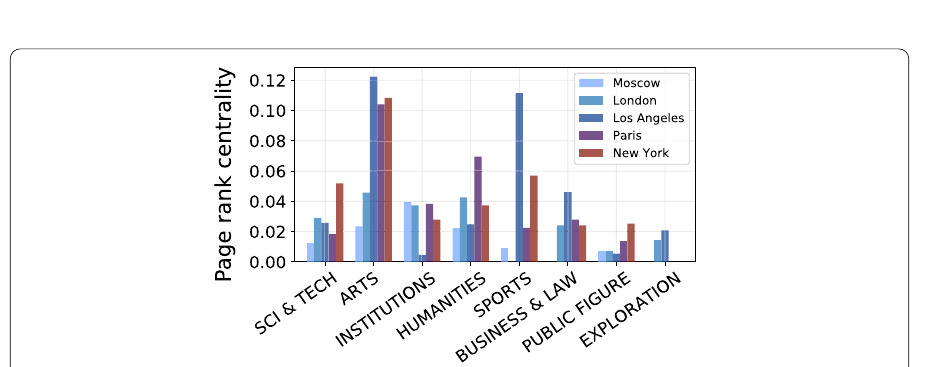
Figure 4 ( A ) Number of different visited cities as a function of the notable birth/death/in-life visited locations. In the case of in-life migrations the number of visited locations does not necessarily corresponds to the number of notable figures in the dataset, but it represents the different cities visited in time as a function of the number of trips made by the notable figures. ( B ) Page-rank centrality for the global mobility network evaluated in two different time-windows. In blue we report the centrality values for the 1900–1925 window, while in red the centrality in the window